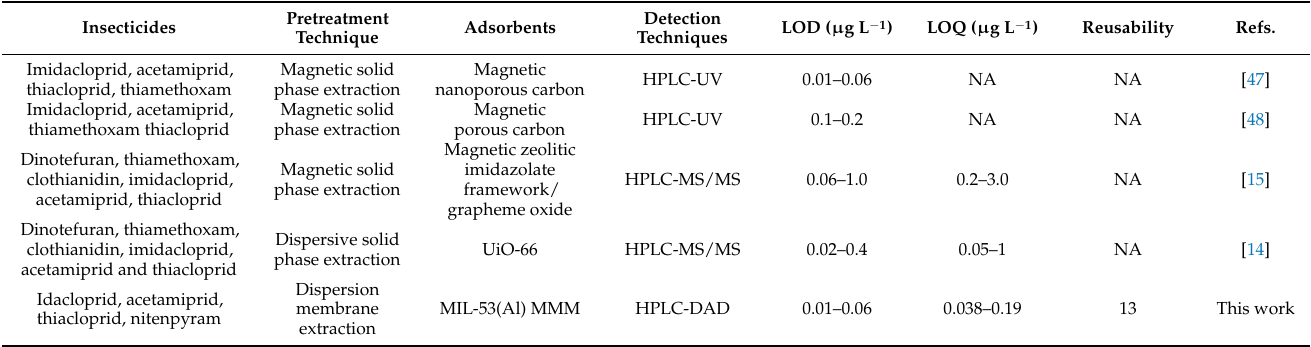
Table 4. Method performance comparison for neonicotinoid insecticides by HPLC in water